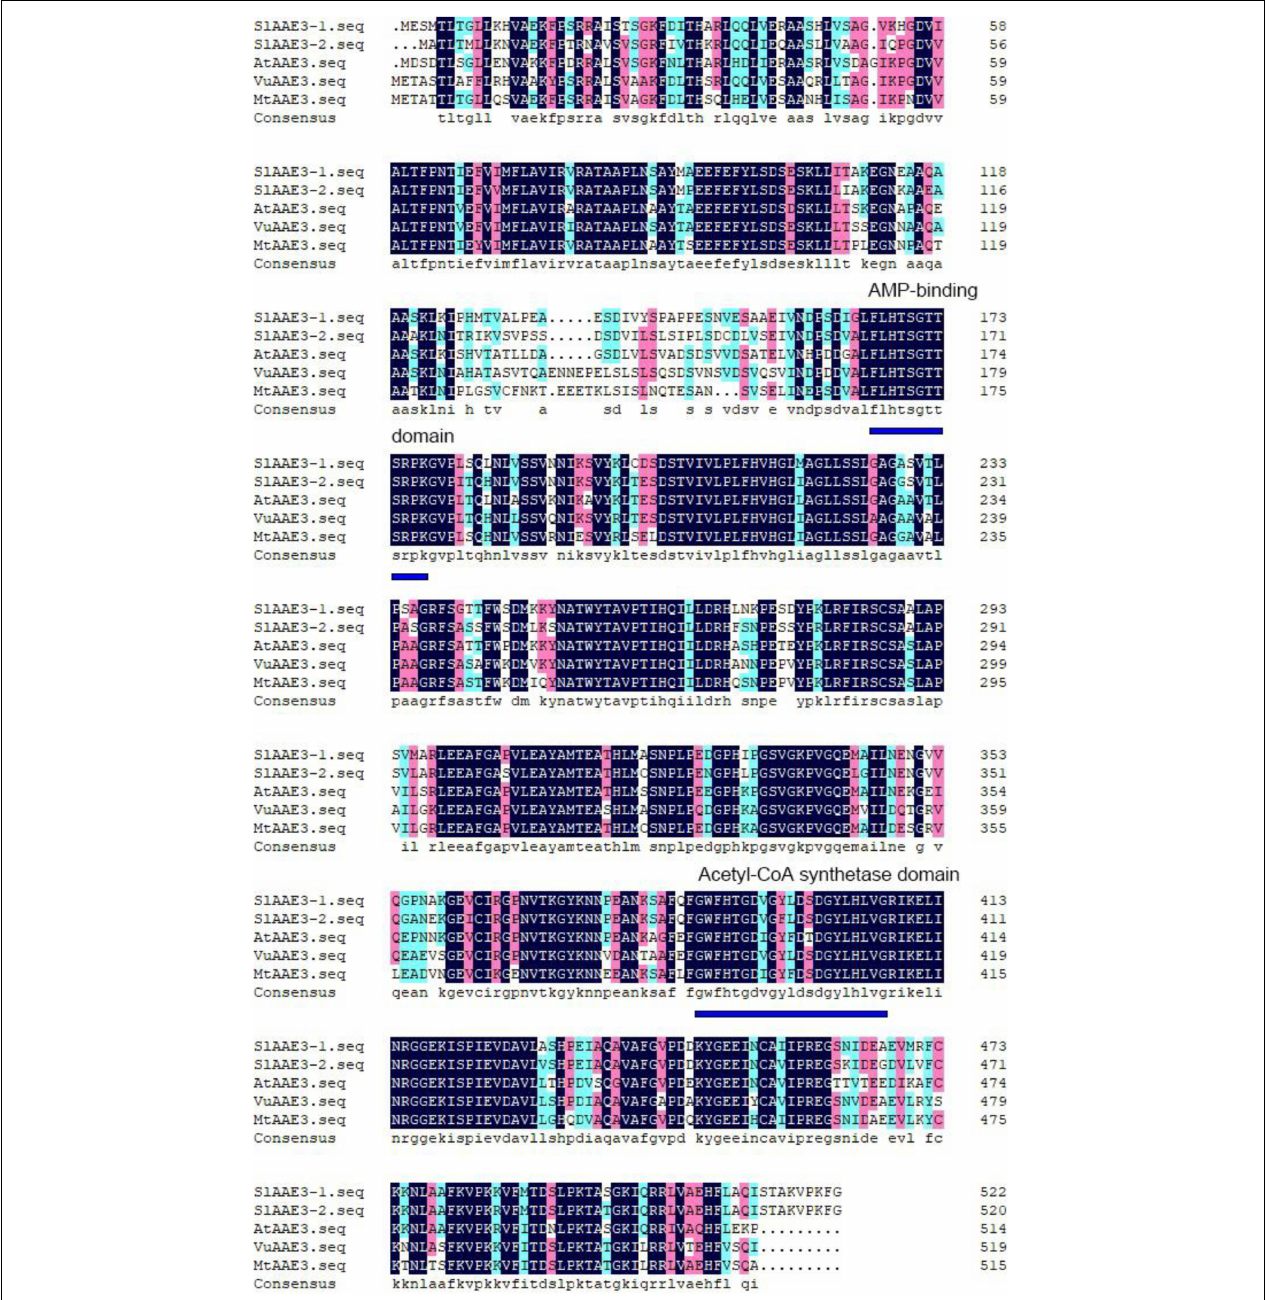
FIGURE 1 | Amino acid sequence alignment of AAE3 proteins from Solanum lycopersicum (SlAAE3-1; Solyc03g025720.2 and SlAAE3-2; Solyc06g035960.2), Arabidopsis thaliana (AtAAE3; At3g48990), Vigna umbellata (VuAAE3; KX354978), and Medicago truncatula (MtAAE3; XP_003599555.1). The conserved AMP binding domain and acetyl-CoA synthetase domain are indicated by blue